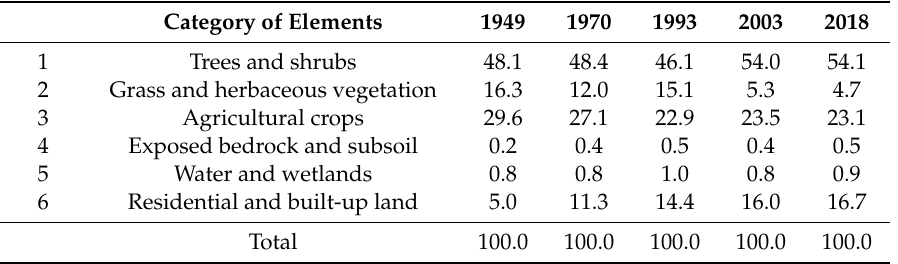
Table 3. The landscape structure elements and their shares in percent related to the survey periods.